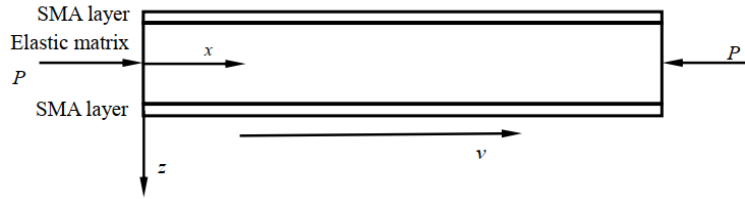
Figure 1. Axially moving SMA laminated beam structural diagram. Hao et al. [28] gives the force diagram of the micro-body. Considering only the transverse vibration equation of the main beam can be